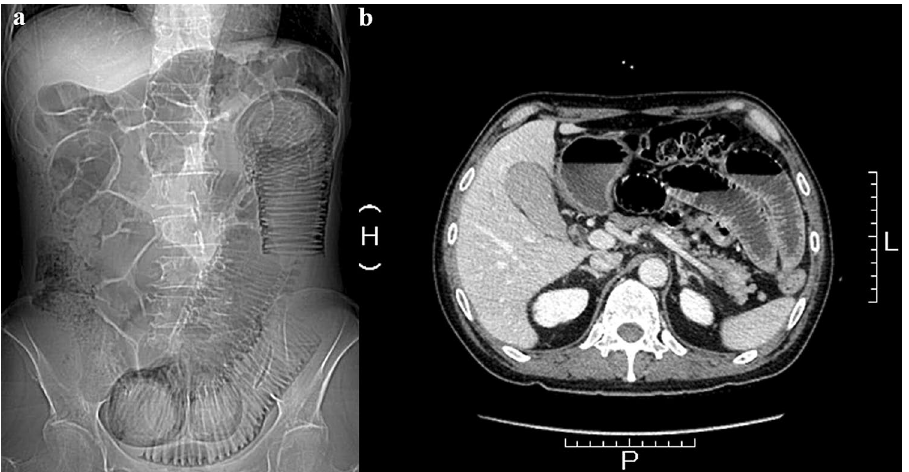
Figure 1. Typical radiological images of chronic intestinal pseudo-obstruction including plain radiograph ( a ) and computed tomography ( b